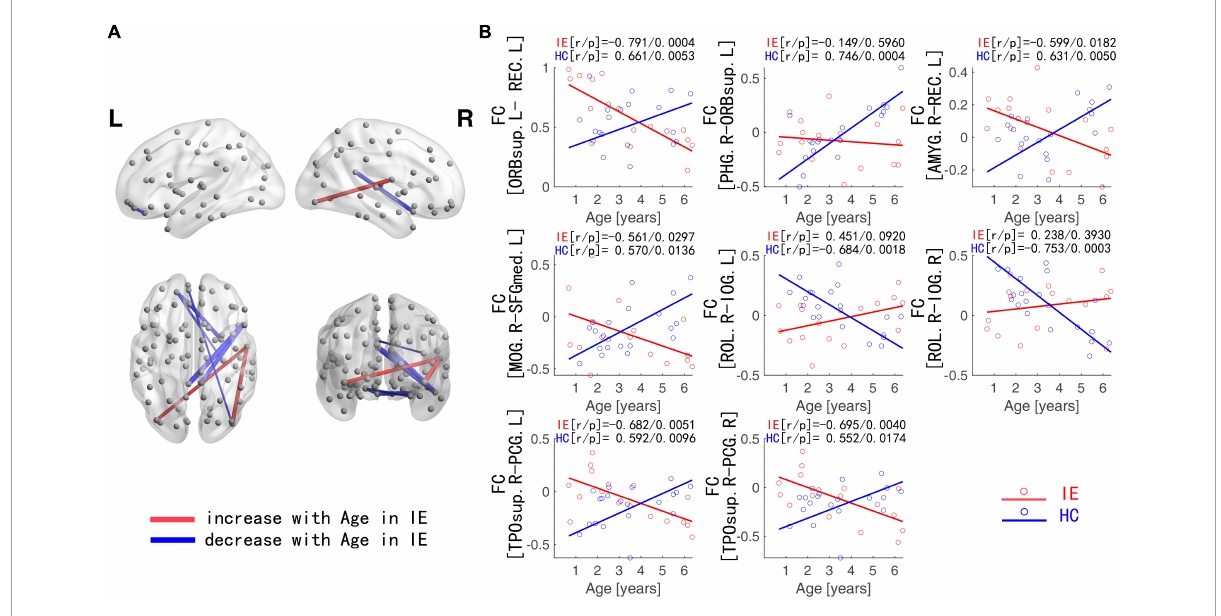
FIGURE2 Functional Connections with Significant Interaction between Group and Age. (A) Blue edges: functional connections with the z-score declining with age in IE patients; Red edges: functional connections with the z -score increasing with age in IE patients. (B) Age-dependent decreased functional connectivity was observed in ORBsup.L-REC.L, PHG.R-ORBsup.L, AMYG.R-REC.L, MOG.R-SFGmed.L, and PCG-TPOsup.R in IE patients in contrast to the increase for HCs, whereas increased functional connectivity with age was found in ROL.R-IOG in IE patients in contrast to the decline for HCs. IE, infantile esotropia; HC, healthy control; L, left; R, right; ORBsup, orbital part of superior frontal gyrus; REC, gyrus rectus; PHG, parahippocampal gyrus; AMYG, amygdala; MOG, middle occipital gyrus; SFGmed, superior frontal gyrus, medial; PCG, posterior cingulate gyrus; TPOsup, temporal pole of superior temporal gyrus; ROL, Rolandic operculum; IOG, inferior occipital gyrus.